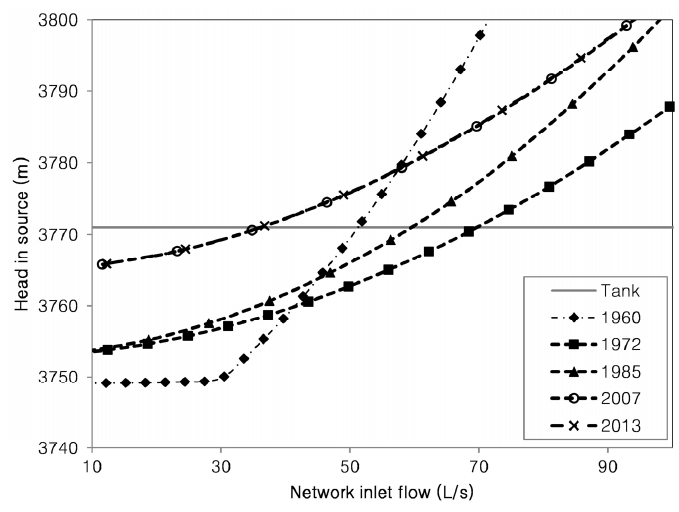
Figure 8. Setting curve in each of the years of study.